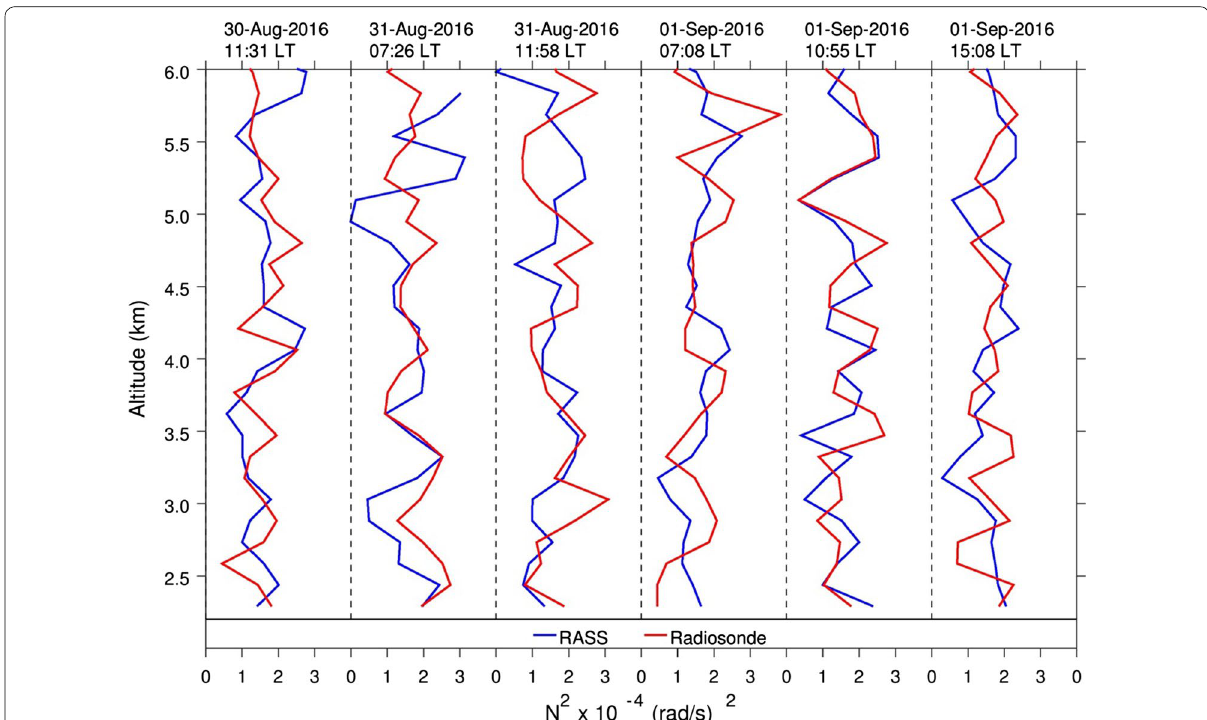
Fig. 18 Comparison of individual N 2 profiles between RASS and radiosondes. The N 2 with RASS is derived from the mean temperature profile aver- aged for one hour after the radiosonde launch